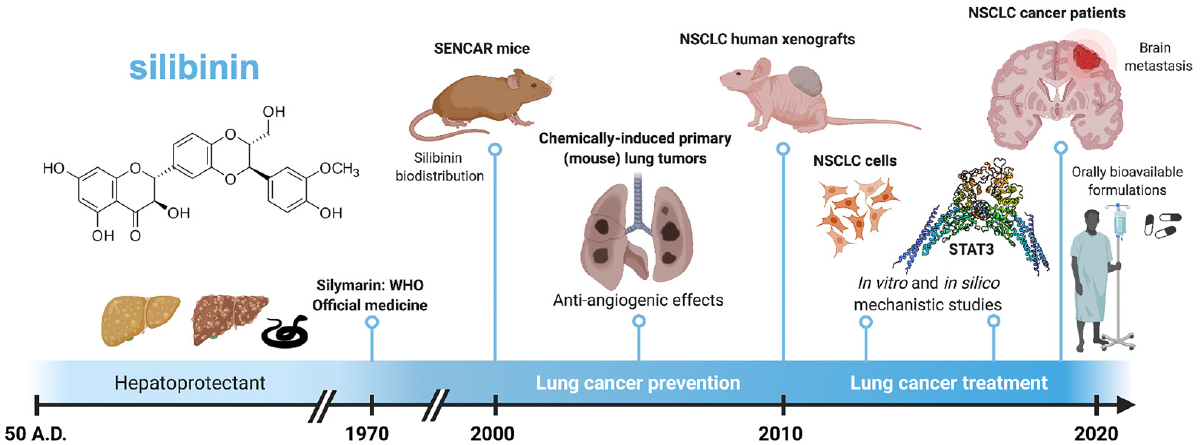
Figure 1. Key milestones in the timeline of silibinin research in lung cancer. Originally employed as a hepatoprotectant and a remedy for the bites of poisonous snakes hundreds of years ago, silibinin has recently demonstrated significant clinical activity in patients with non-small cell lung cancer and brain metastases when used in new orally bioavailable formulations. Created with BioRender.